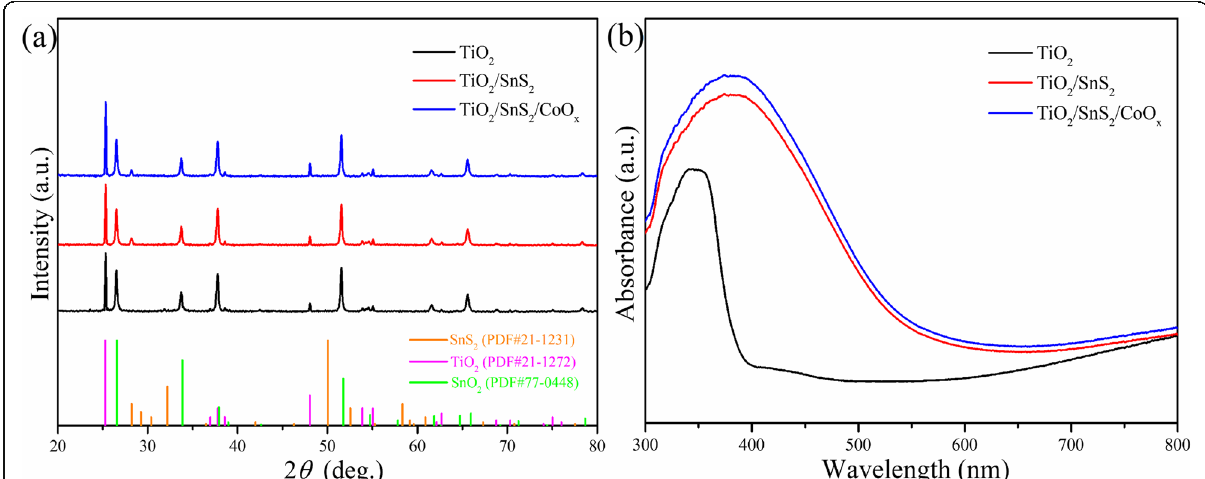
Fig. 2 a XRD pattern and b absorption spectra of pristine TiO 2 , TiO 2 /SnS 2 and TiO 2 /SnS 2 /CoO x nanosheet